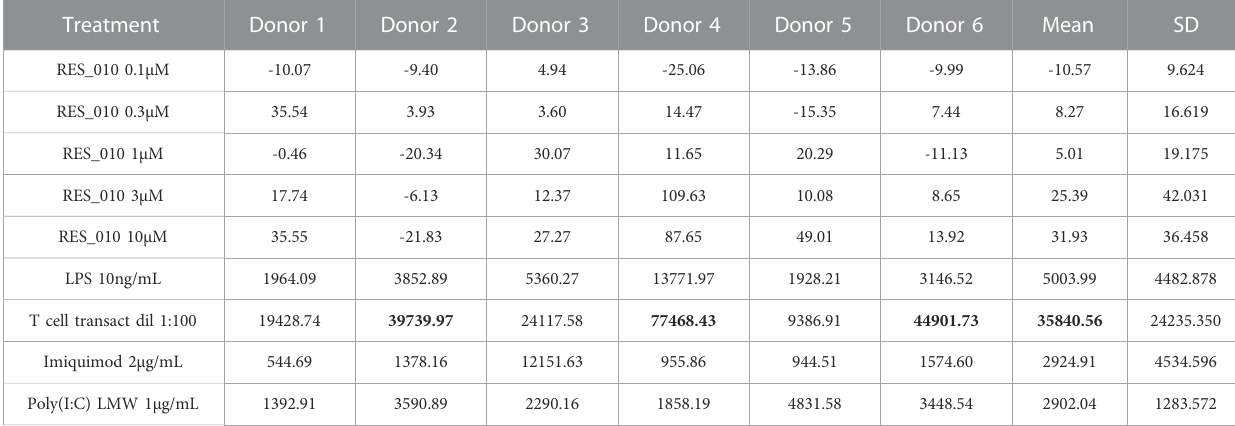
TABLE 3 Concentration Data Vehicle Corrected (pg/mL) for Cytokines: IFN- γ .